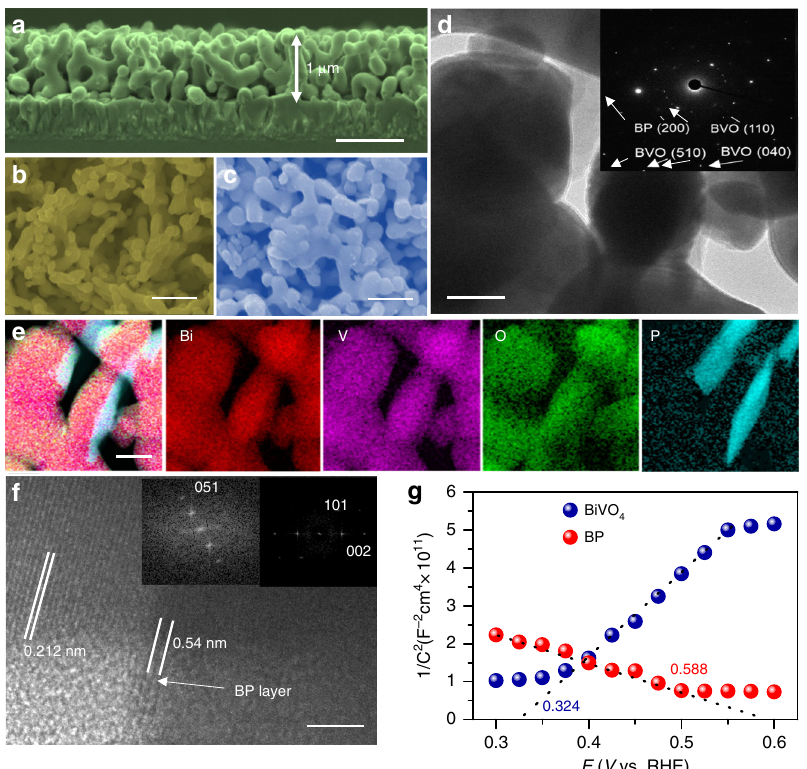
Fig. 1 Morphology and conductivity characterizations. a Cross-section SEM image, scan bar: 1 μ m. b Top view SEM images of as-prepared BiVO 4 photoanode and ( c ) the top view SEM image of BP/BiVO 4 photoanode, scan bar: 500 nm. d TEM image of BP/BiVO 4 photoanode, scan bar: 100 nm, insert is electron diffraction spot. e HAADF-STEM-EDX element mapping and f HR-TEM image of BP/BiVO 4 heterojunction, scan bar: 5 nm. g Mott-Schottky plots of BP and BiVO 4 electrodes measured with a frequency of 500 Hz and amplitude of 10 mV in KPi electrolyte (pH = interface 34 . As shown in the Bi 4f (Fig. 2a) and O 1 s /V 2 p (Fig. 2b) XPS spectra, the Bi 4f 7/2 core-level and O 2 p core-level spectra of BP/BiVO 4 shift by 0.3 and 1.58 eV, respectively, to